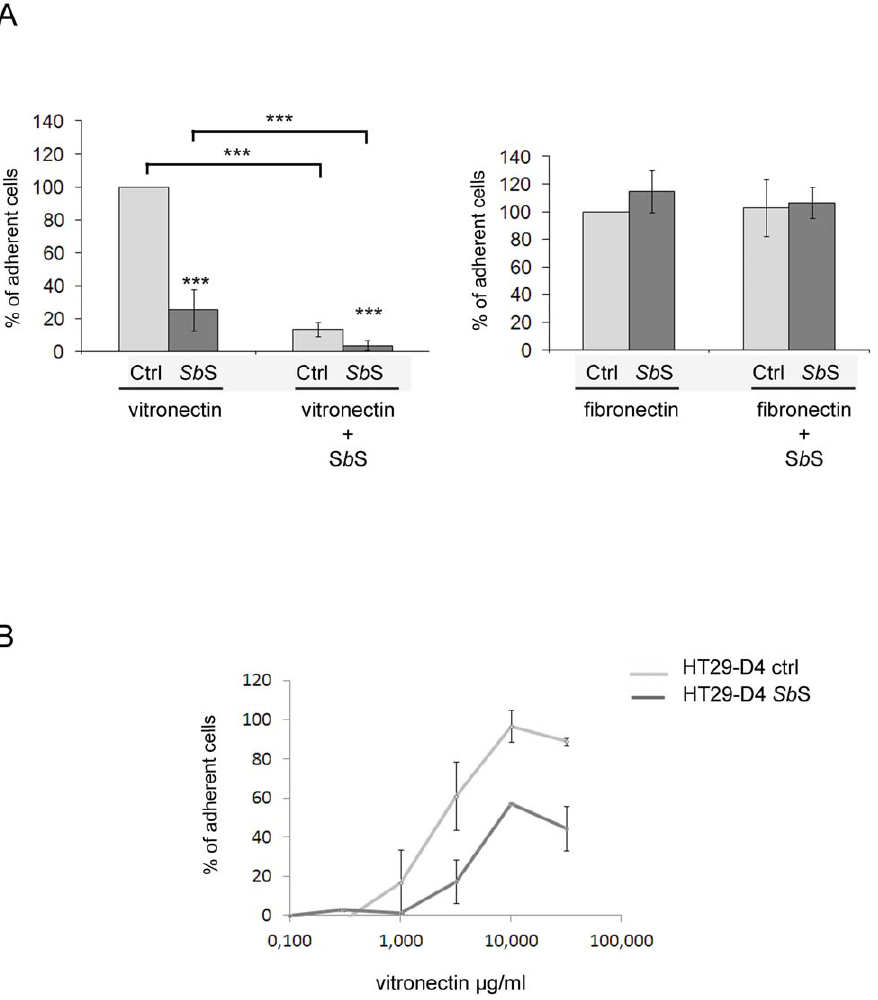
Figure 6. Sb S blocked a v b 5 integrin interaction with vitronectin. (A) Vitronectin- or Fibronectin-coated plates were incubated in the absence (Vitronectin and Fibronectin) or presence of Sb S (vitronectin + Sb S and fibronectin + Sb S) prior to addition of cells. Isolated HCT-8/E11 cells incubated without (light bars) or with Sb S (dark bars) were then seeded on plates. Cell adhesion to ECM was evaluated as described in Methods. Results are expressed as the percentage of cell adhesion compared to untreated cells (Ctrl). Data represent the mean + SD of 3 separate experiments. (B) Isolated HT29-D4 cells were treated with or without Sb S (dilution 1/8) and plated on vitronectin at the indicated concentrations. Cell-vitronectin adhesion was evaluated as described in Methods. Results are expressed as the percentage of cell adhesion. Data represent the mean + SD of 3 separate experiments. *** P , 0.001.